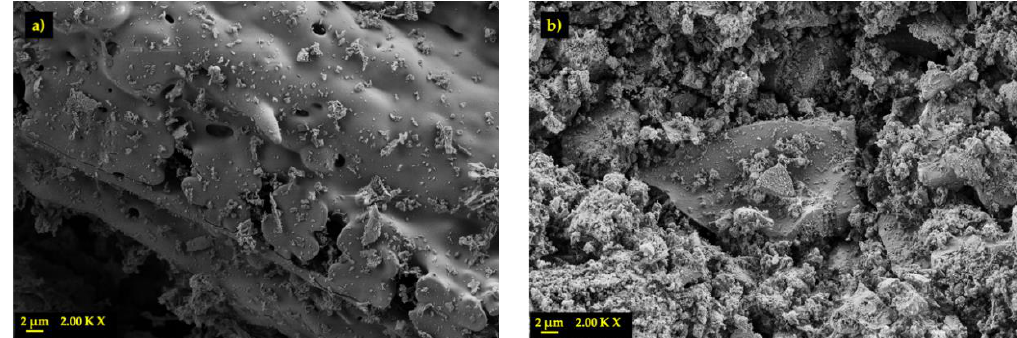
Figure 5. FESEM micrographs of RSA: ( a ) original; ( b ) milled.